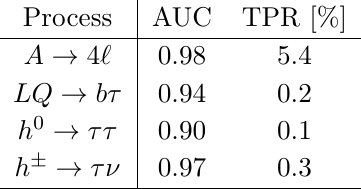
Table 2 . Classi(cid:12)cation performance of the four BDT classi(cid:12)ers described in the text, each trained on one of the four BSM benchmark models. The two set of values correspond to the area under ROC curve (AUC), and to the true positive rate (TPR) for a SM false positive rate (cid:15) SM = 5 : 4 (cid:1) 10 (cid:0) 6 , i.e., to (cid:24) 1000 SM events accepted every